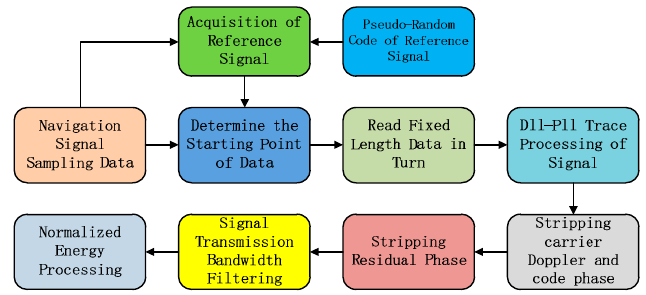
Figure 3. Refined signal software receiving and processing technology.